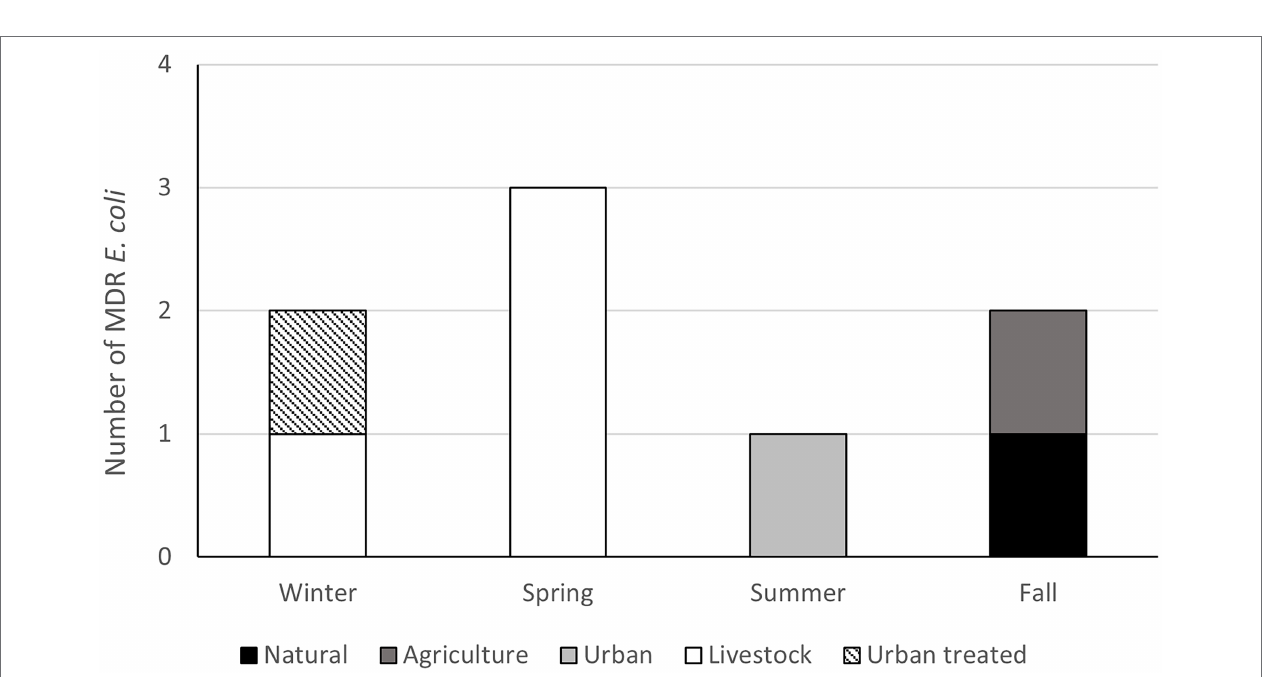
FIGURE 5 | Conditional inference trees were used to visualize hierarchical relationships between environmental factors and if Giardia cysts were detected or not. The black bar in each plot shows the probability of Giardia being detected when the given conditions were met. For example, the lowest probability of Giardia detection was in samples collected from sites with a predominant land use that was agricultural, livestock, natural or urban (as opposed to sites at a wastewater discharge) in the wet season.